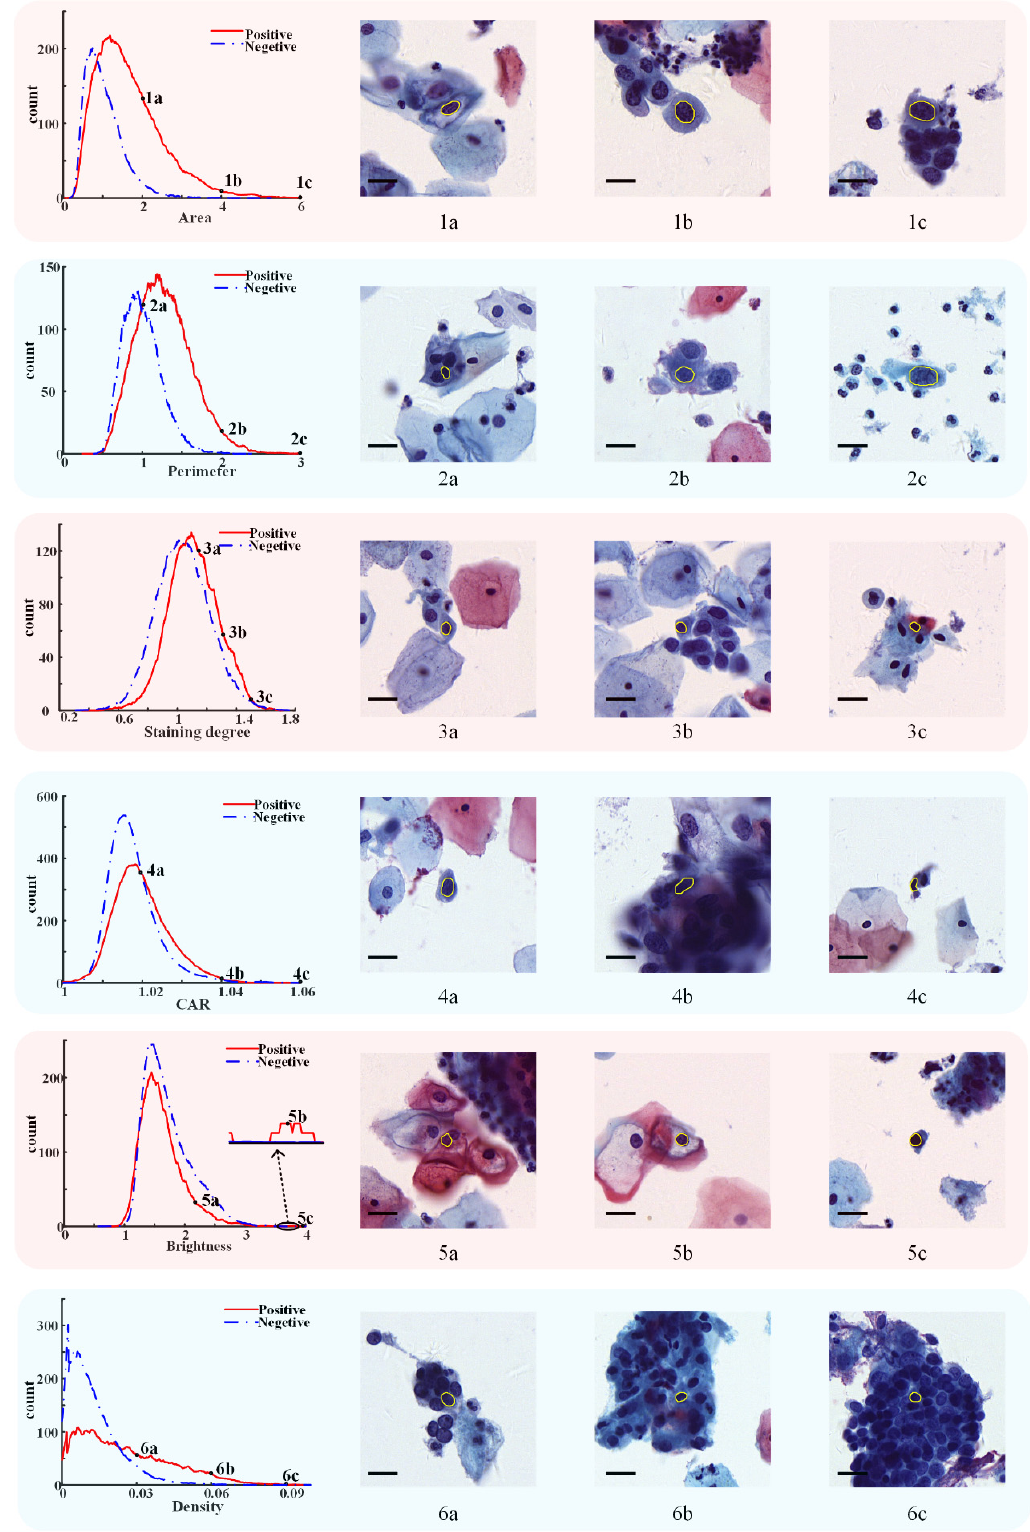
Fig. 2. Distribution of features and typical positive nuclei with di®erent values of features. The nucleus circled by the yellow outline in each patch is a typical sample corresponding to the feature equal to a speci¯c value, and these nuclei are from training set. Scale bar: 20 (cid:5)